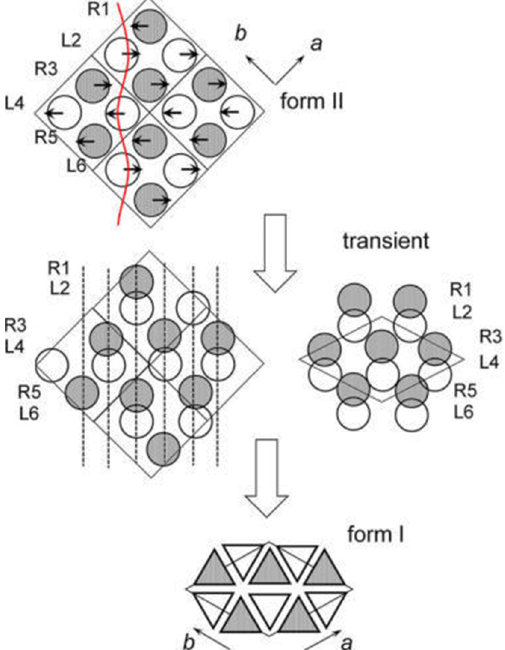
Figure 25. A possible phase transition model of iPBu crystal from form II to form I proposed by Tashiro et al. The R and L chains move to the mutually opposite direction with the phase angle π along the [110] direction. This translational lattice mode results in the formation of a transient structure, which transforms to the chain packing mode of form I. The change in chain conformation is ignored here, which should occur cooperatively in parallel to the translational mode shown here. Reproduced with permission from Ref. [23], copyright 2016 American Chemical Society.